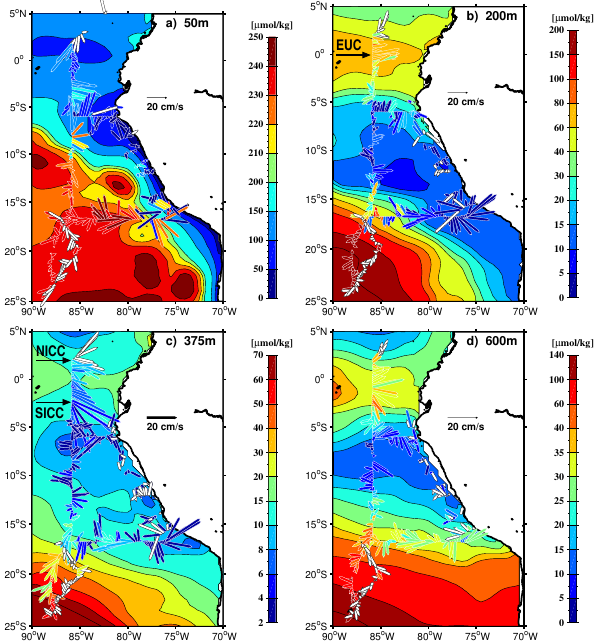
Figure 3. Horizontal distribution of ADCP velocity vectors at (a) 50m, (b) 200m, (c) 375m, and (d) 600m depth recorded in November and December 2012 with current vectors colored with oxygen (in µmolkg − 1 ) of the accompanying CTD-oxygen mea- surement at this depth. In case of no accompanying CTD-oxygen measurement the current vectors are white. The oxygen distribution of the background field is from the CARS 2009 climatology (Ridg- way et al., 2002) for November at 50, 200, and 375m and the annual mean at 600m depth. Please note the different color scales adjusted to fit the corresponding depth layer oxygen range. The locations of the equatorial undercurrent (EUC) and the Northern and Southern Intermediate Current (NICC, SICC) are